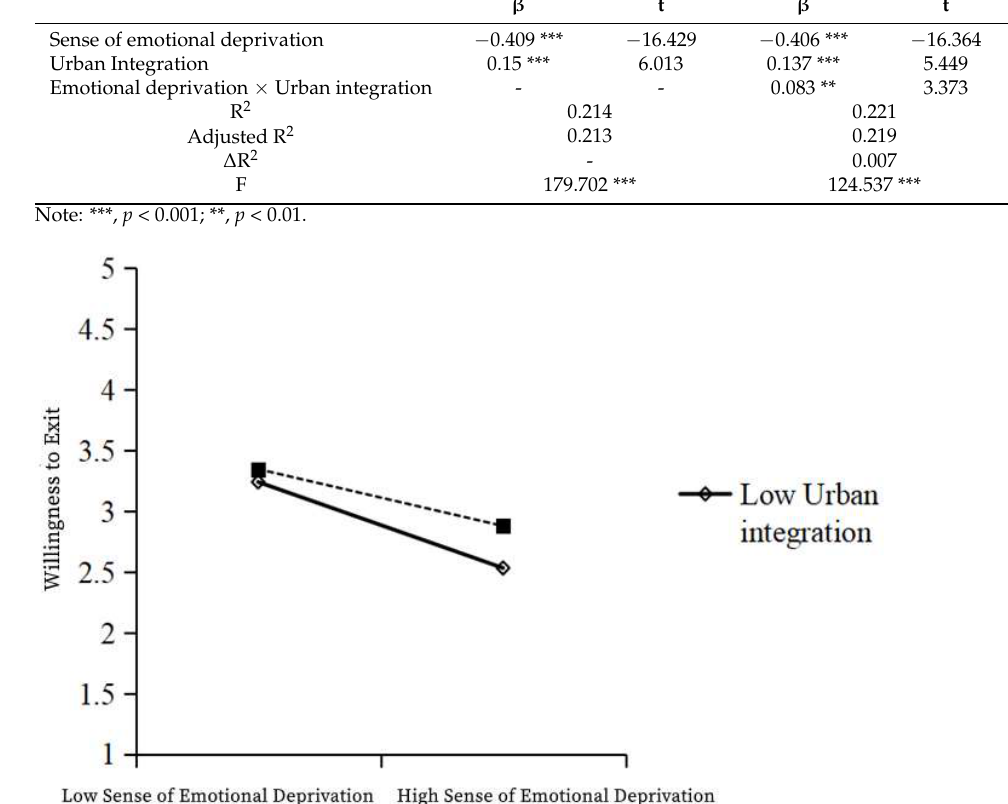
Figure 6. Moderating effect of urban integration between the sense of emotional deprivation and willingness to withdraw.